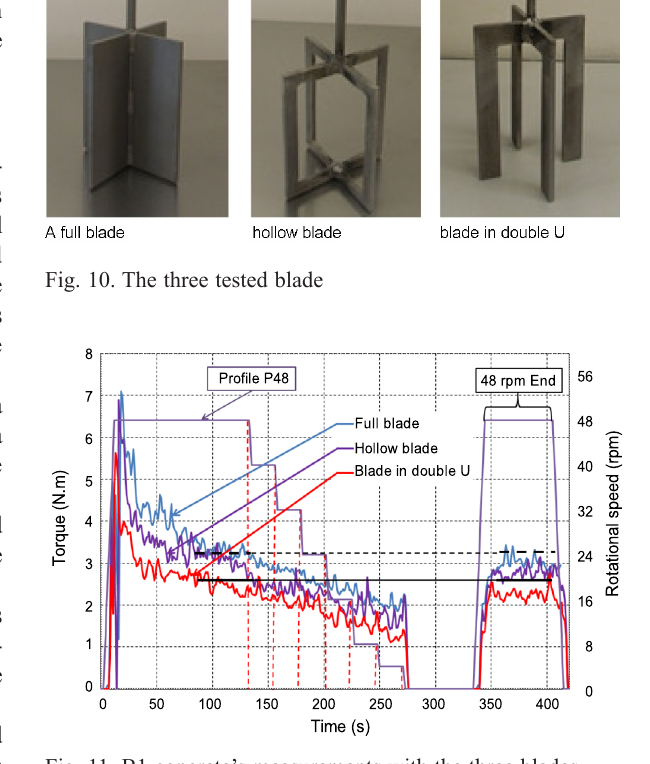
Fig. 11. B1 concrete’s measurements with the three